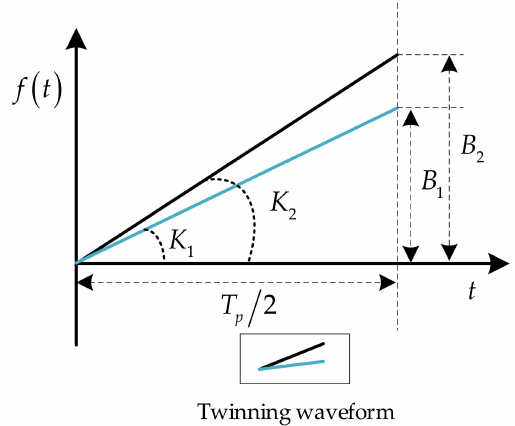
Figure 1. Sketch map of the instantaneous frequency of the twinning